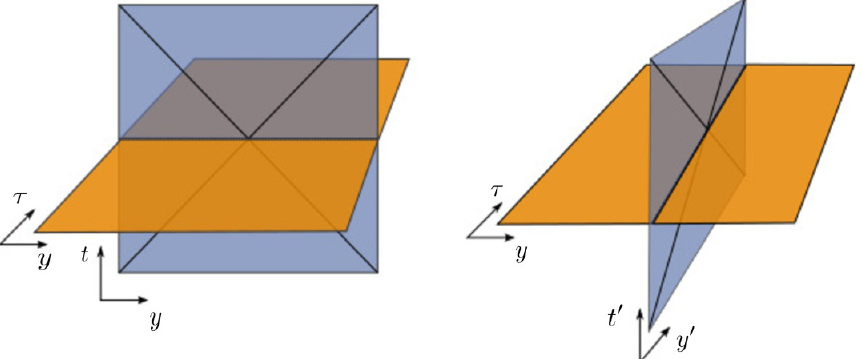
(cid:2) 0 (cid:2) 0 . h i